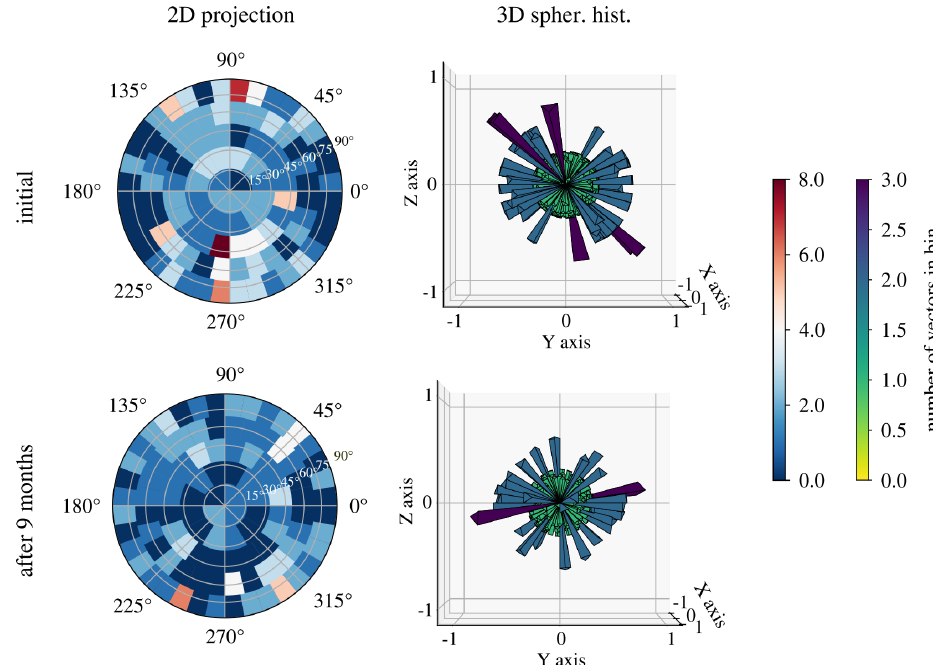
Figure 5. Spherical histogram of the minimum eigenvector of the inclusions and the cracks in sample A, initially and after 9 months of exposure to CO 2 (colour represents the number of projected points per bin divided by the median number of points in all